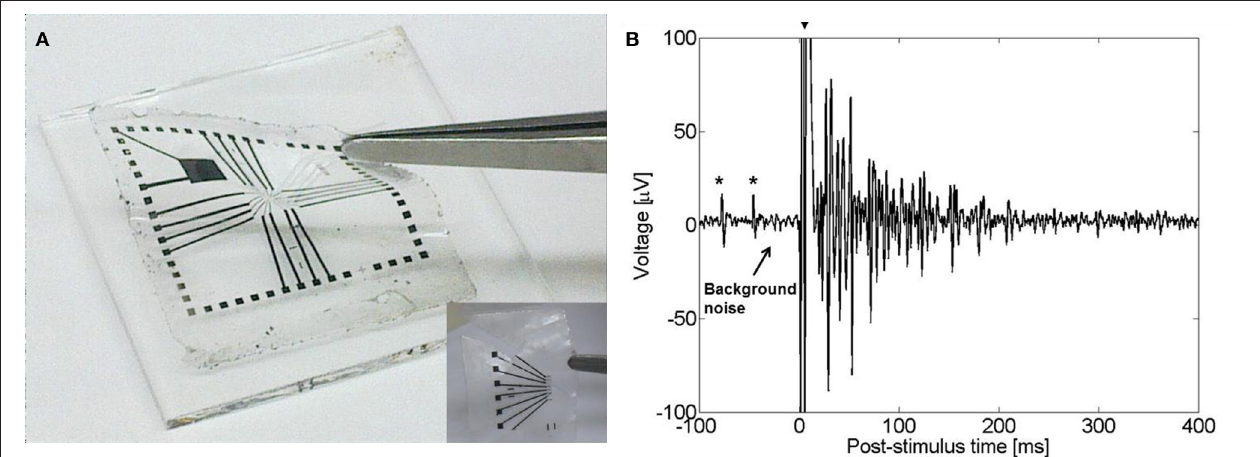
FIGURE 6 | (A) A flexible CNT-based MEA. Inset: flexible CNT-based MEA designed for in vivo applications. ( B ) Evoked electrical activity recorded from an embryonic chick retina (day 14) by a CNT electrode (one out of sixteen 50 µ m diameter electrodes in the array) using a biphasic anodic first pulse of